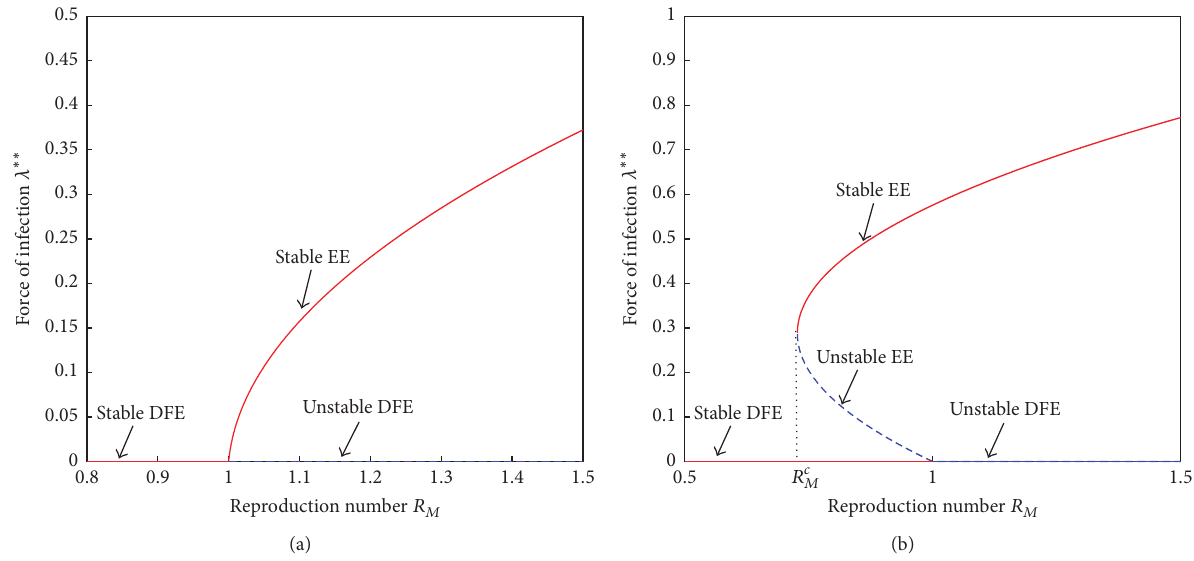
Figure 3: Forward bifurcation for 𝑅 𝑀 = 3.11 in (a) and backward bifurcation for 𝑅 𝑀 = 0.95 in (b) with 𝑅 𝑐 𝑀 = 0.68 .